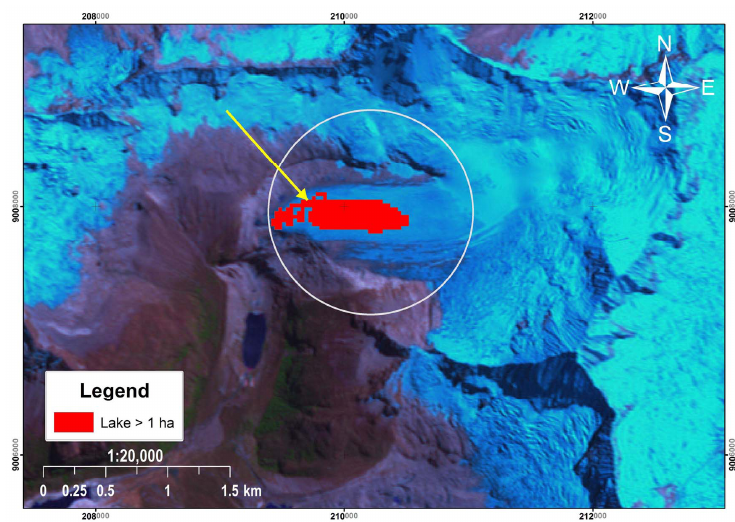
Figure 5. Identification of an overdeepening in the bed of Glaciar Artesonraju (Cordillera Blanca) with possible lake formation: ice-thickness distribution ( top , maximum calculated ice thickness is 186 m) and glacier-bed overdeepening ( bottom ), both from the GlabTop model. The pond now already visible in nature (Figure 1) at the western glacier margin may be connected (arrow) at the orographic right (northern) side of the flat glacier tongue with a larger lake probably forming at a later stage. Image SPOT 5 of 2003.